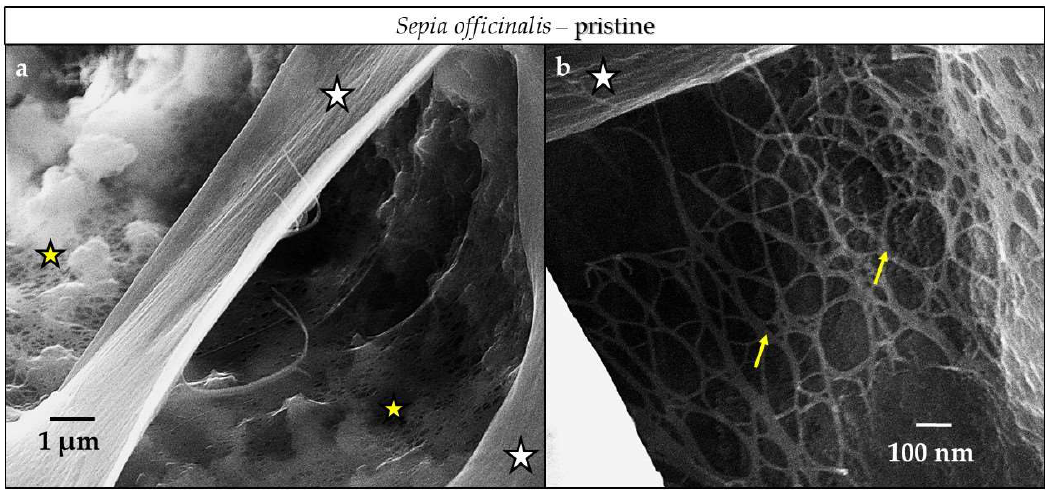
Figure A14. FE-SEM images of biopolymer membranes (white stars in ( a , b )), biopolymer networks (yellow arrows in ( b )) and biopolymer foams containing nanoparticulate aragonite (yellow stars in ( a )) in the cuttlebone of pristine Sepia officinalis .